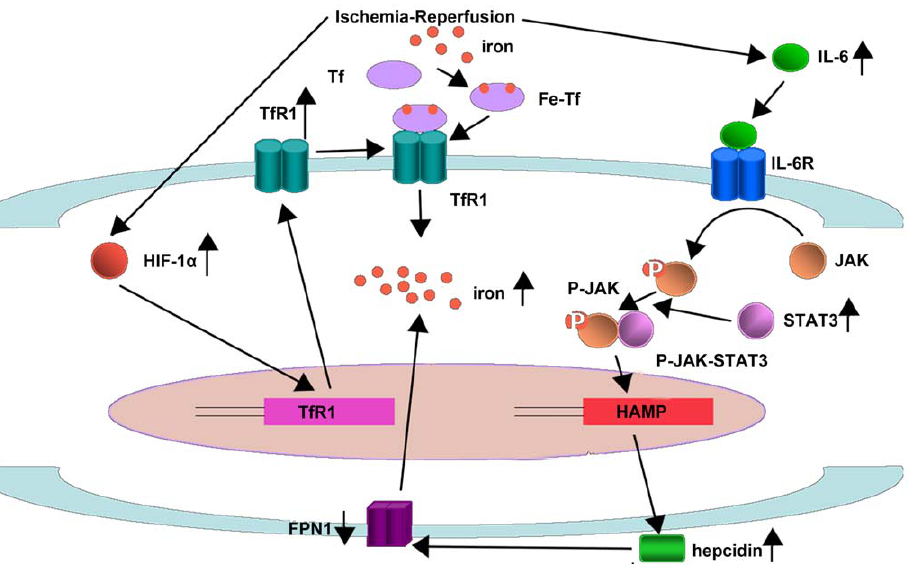
Figure 11. Proposed pathways for the regulation of the iron level in cerebal ischemia. Tf: Transferrin; TfR1: Transferrin receptor; TfR1: gene of Transferrin receptor; HIF-1 a : Hypoxia-inducible factor-1 a ; FPN1: Ferroportin1; IL-6: Interleukin-6; IL-6R: Interleukin-6 receptor; HAMP: gene of hepcidin; STAT3: Signal transducing activator of transcription-3.